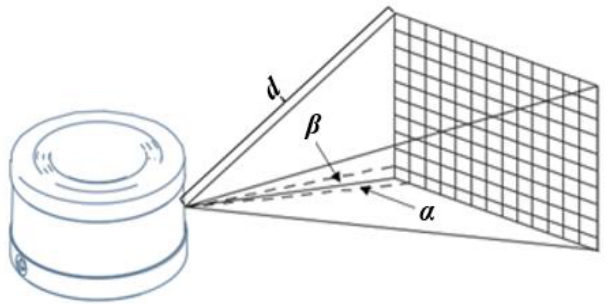
Figure 11. Schematic Diagram of the Projection